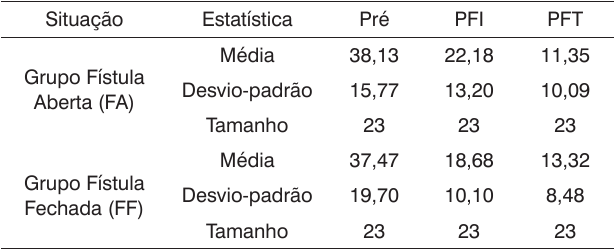
Tabela 3. Médias (mV) e desvios-padrão (mV) da amplitude do PA nos diferentes momentos do estudo.